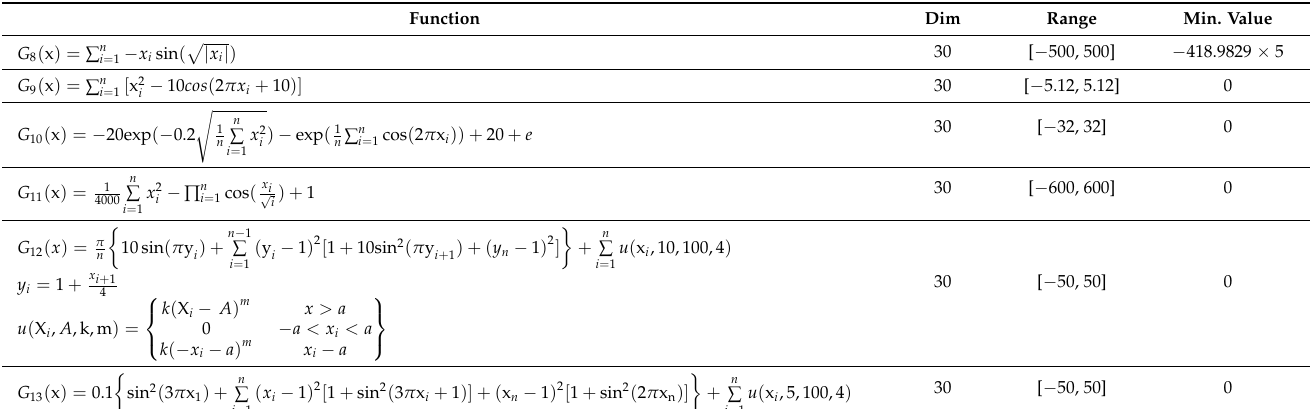
Table 3. Multimodal Benchmark Functions.